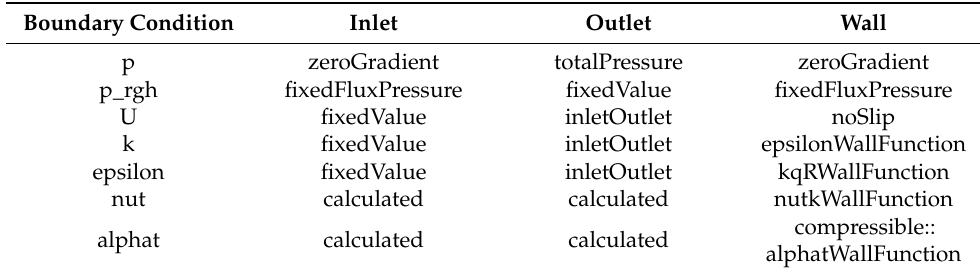
Table 2. Setup of additional boundary conditions for CFD simulation.